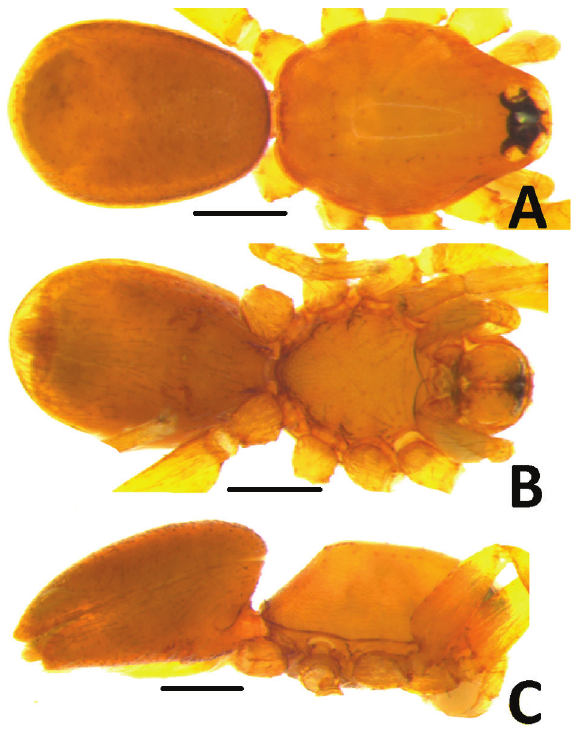
Figure 16. Silhouettella saaristoi n. sp., male from Labugama FR: A , habitus, dorsal view; B , same, ventral view; C , same, lateral view. Scale bars: 0.2